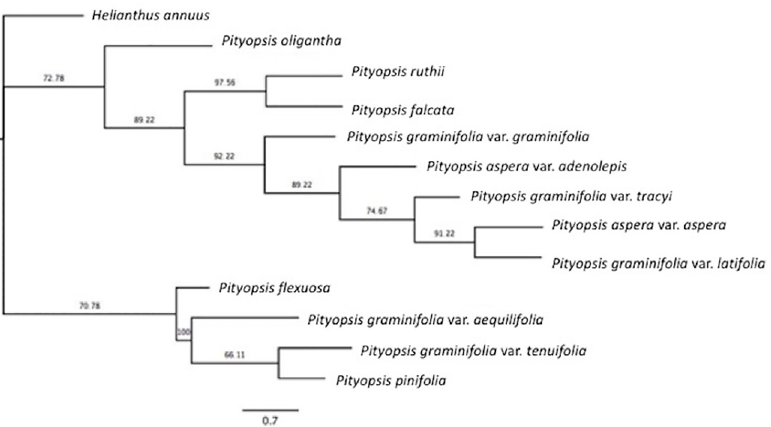
Fig 3. Phylogenetic tree constructed from nuclear ribosomal region of all sampled Pityopsis taxa with related species Helianthus annuus as an outgroupusing the maximum likelihood approach. The tree was constructed using the GTR + GAMMA model within RAxML with 1000 replicates. A consensus tree was built using a 50% support threshold. Numbers above nodes are bootstrap values ( > 50%).